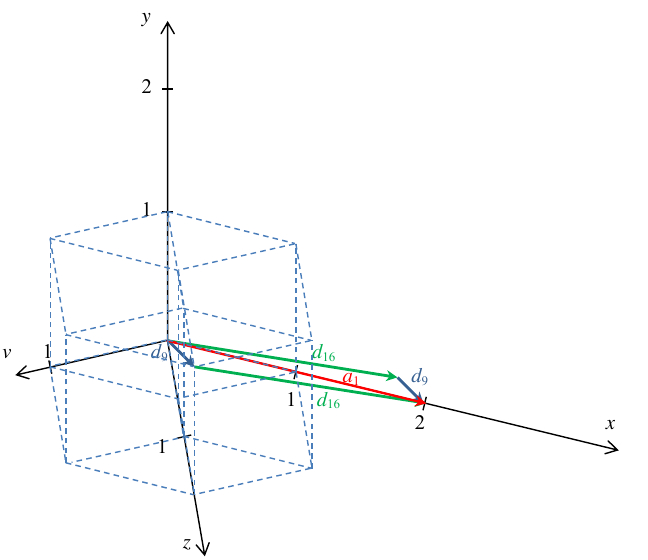
Figure 2. The sum of vectors d 9 and d 16 is exactly the vector a 1 in the four-dimensional BCC grid. A unit hypercube is also shown.